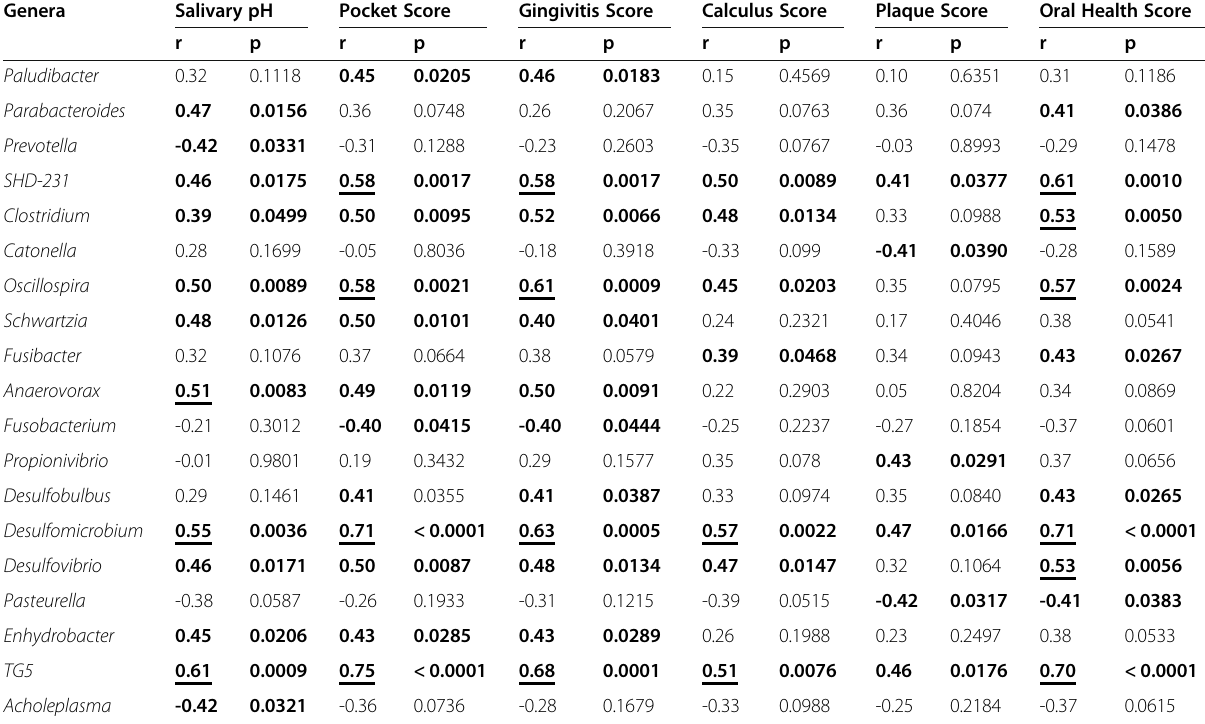
Table 9 Correlation coefficients (r) between oral health scores, plaque scores, calculus scores, gingivitis scores, pocket scores, pH and bacteria genera in saliva samples 1